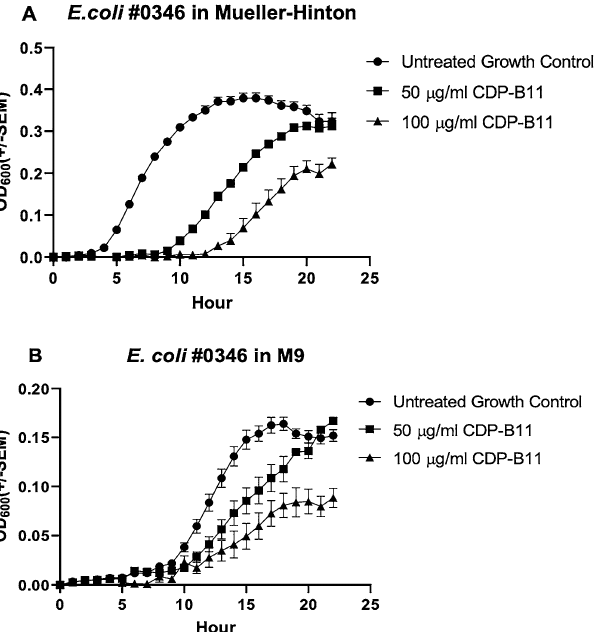
Figure 2. Growth curves (OD 600 ) for E. coli #0346 over 22 h. No treatment (circles), with CDP-B11 (50 μg/mL, squares; 100 μg/mL, triangles) using ( A ) Mueller–Hinton media, or ( B ) M9 media.